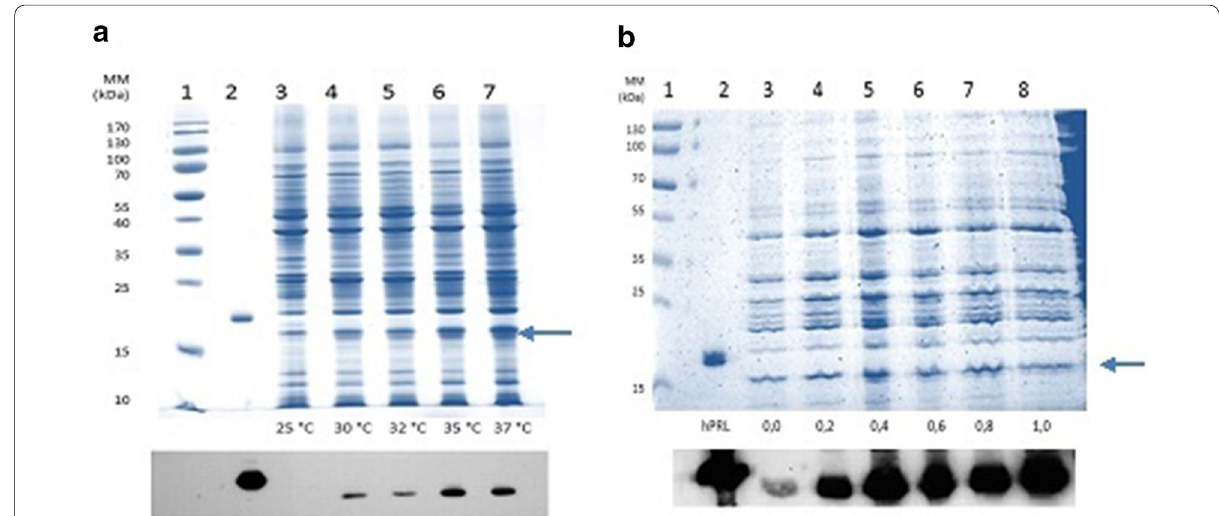
Fig. 1 SDS-PAGE under non-reducing conditions and Western Blotting with samples of periplasmic fluid obtained from E. coli BL21(DE3) by osmotic shock, after 5 h of cultivation with 0.4 mM IPTG at different temperatures: 25 °C, 30 °C, 32 °C, 35 °C and 37 °C ( a ) and at 25 °C with different IPTG concentrations: 0.2 mM, 0.4 mM, 0.6 mM, 0.8 mM and 1.0 mM. b Lane 1: molecular mass marker, lane 2: recombinant human prolactin internal standard (23 kDa). The arrows indicate the position of Δ 1-11 -G129R-hPRL (22 kDa)